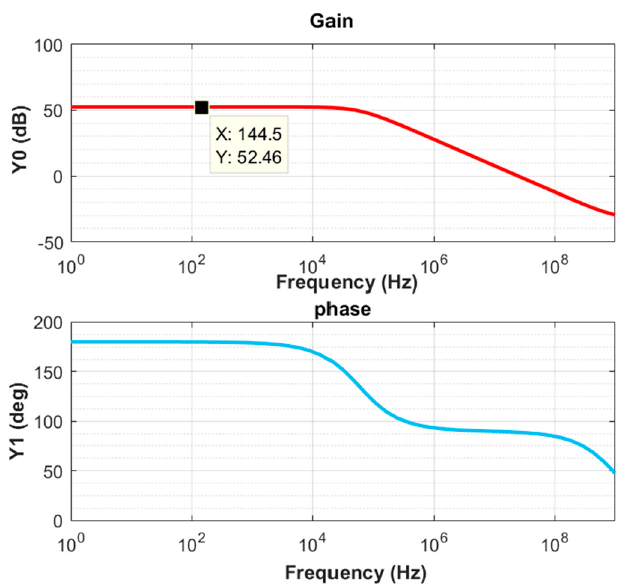
Figure 6. The proposed inverter-based AC gain and phase diagrams. Common-mode voltage gain (AC) and differential voltage gain (AD) of the proposed amplifier are plotted in Figure 7. AC is lower than 1; therefore, the common mode rejection ratio (CMRR) is greater than AD and equals 64.53 dB, while AD and AC equal 52.46 dB and − 12.07 dB, respectively.